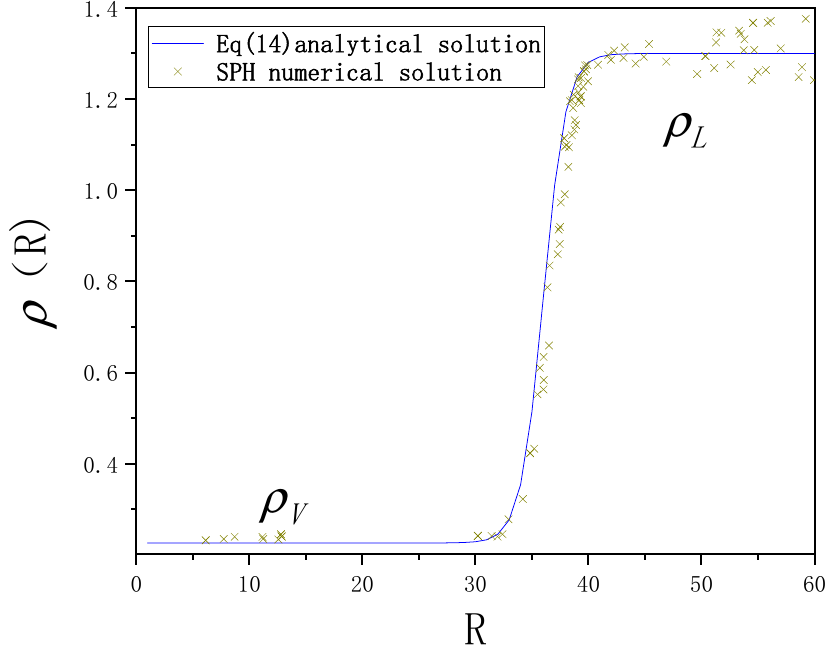
Figure 2. Radial density distribution of fluid across the bubble interface. According to the curve slope of the bubble radius with time, three control mechanisms could be observed during bubble growth, categorized into the (a) inertia-controlled stage, (b) transition stage, and (c) thermally controlled stage. Lee and Merte [17] found that the curve slope in Stage (a) is twice as much as that in Stage (c) in logarithmic coordinates, as shown in Figure 3a. Our simulation obtained the logarithmic fitting coefficients for the radius to time as 2.2098 and 1.1043 in Stages (a) and (c), respectively, as shown in Figure 3b. This ratio is approximately 2:1, which is consistent with the analytical results of Lee and Merte.